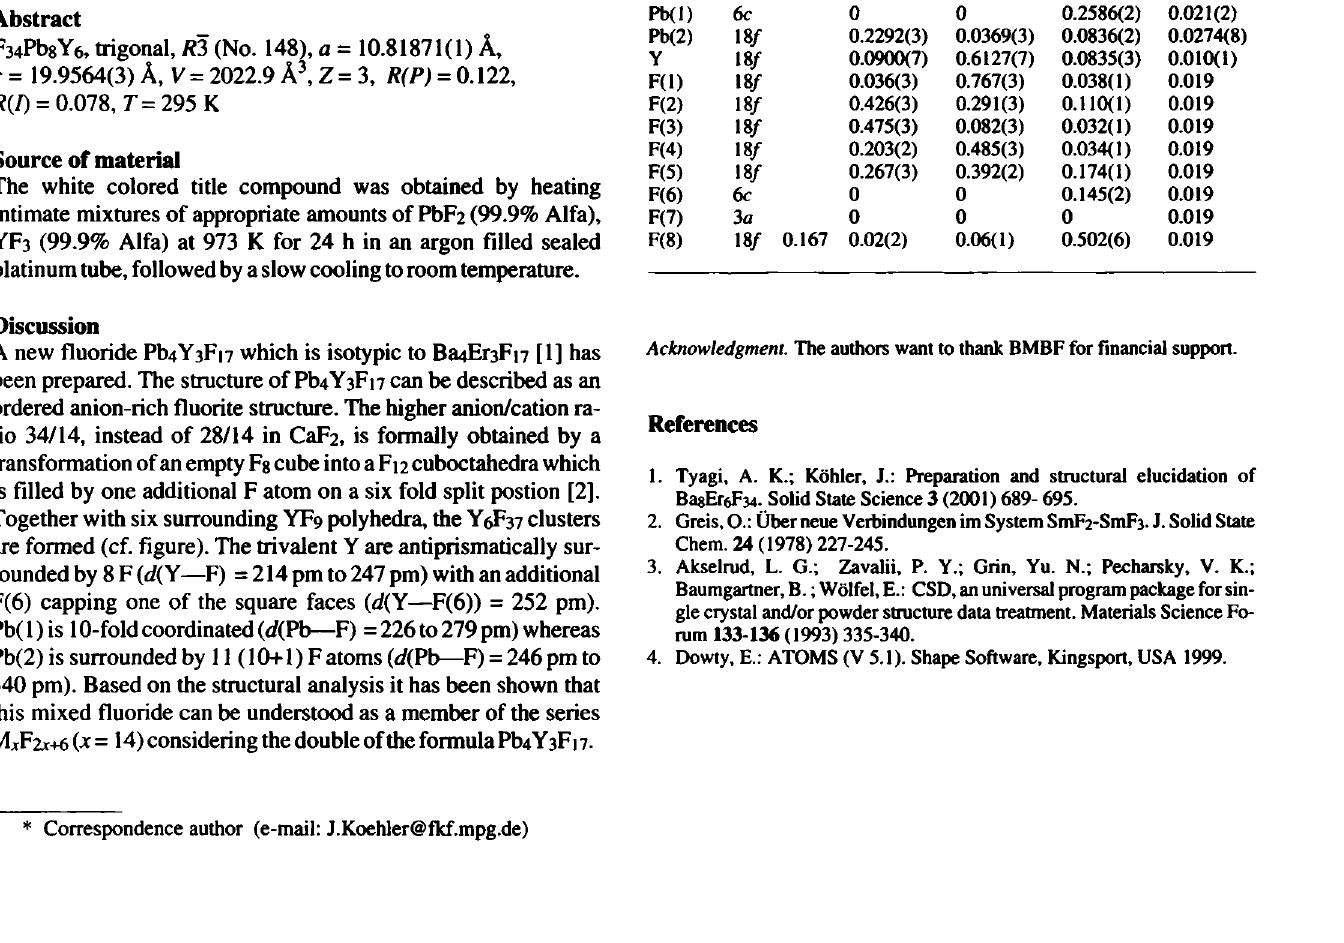
Table 2. Atomic coordinates and displacement parameters (in Â 2